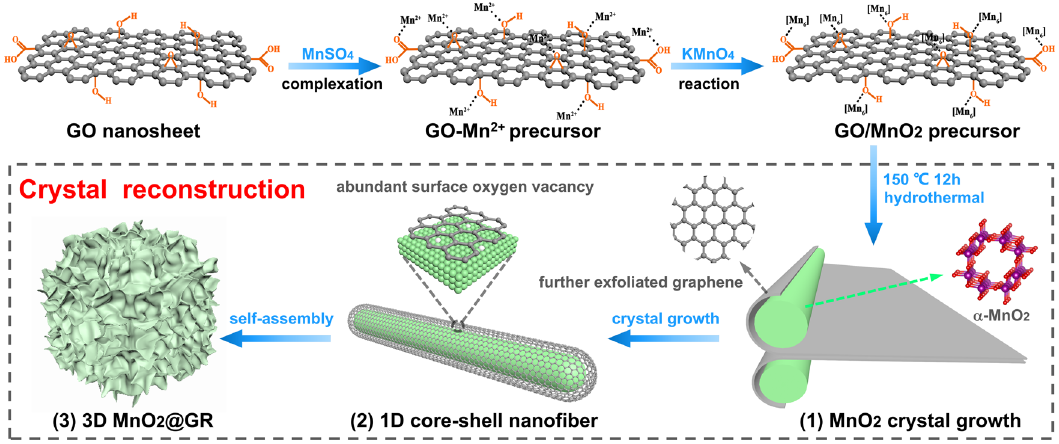
Fig. 1 Schematic illustration of the synthetic route and model of the 3D hierarchical MnO 2 @GR. The 3D hierarchical MnO 2 @GR catalysts were synthesized via the processes of the complexation of MnSO 4 , oxidation of KMnO 4 , the crystal growth of MnO 2 under hydrothermal condition and self- assembly of 1D core – shell nano fi